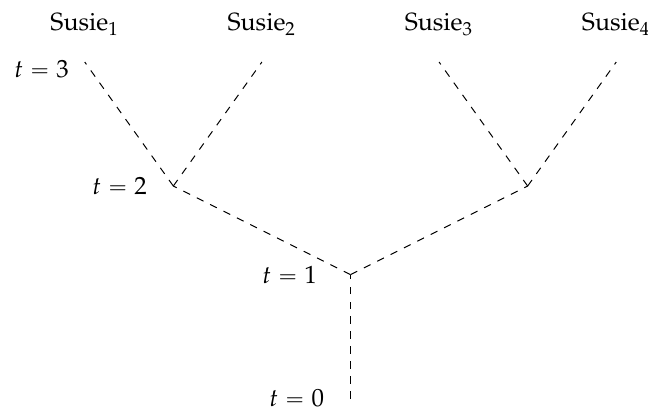
Figure 1. Branching